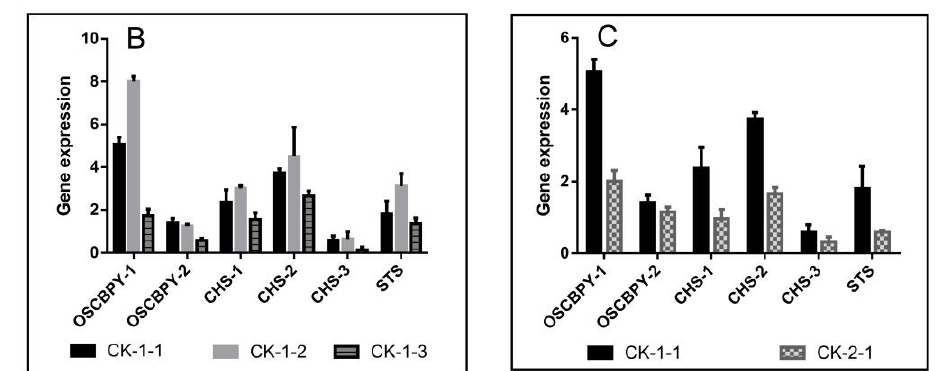
Figure 8. Expression of DEGs related to secondary metabolite synthesis. ( A ): Heatmap of DEGs expression in the flavonoid synthesis pathway under different treatments; ( B ): Expression of common DEGs related to secondary metabolites under different stress times (CK-1-1 vs. CK-1-2 vs. CK-1-3); ( C ): Expression of DEGs related to secondary metabolites under different stress temperatures (CK-1-1 vs. CK-2-1).